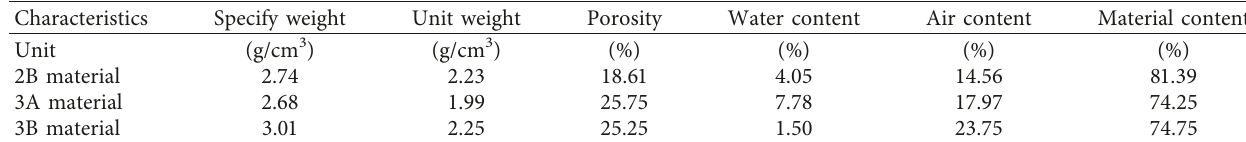
Table 1: Material properties of the Ilısu dam